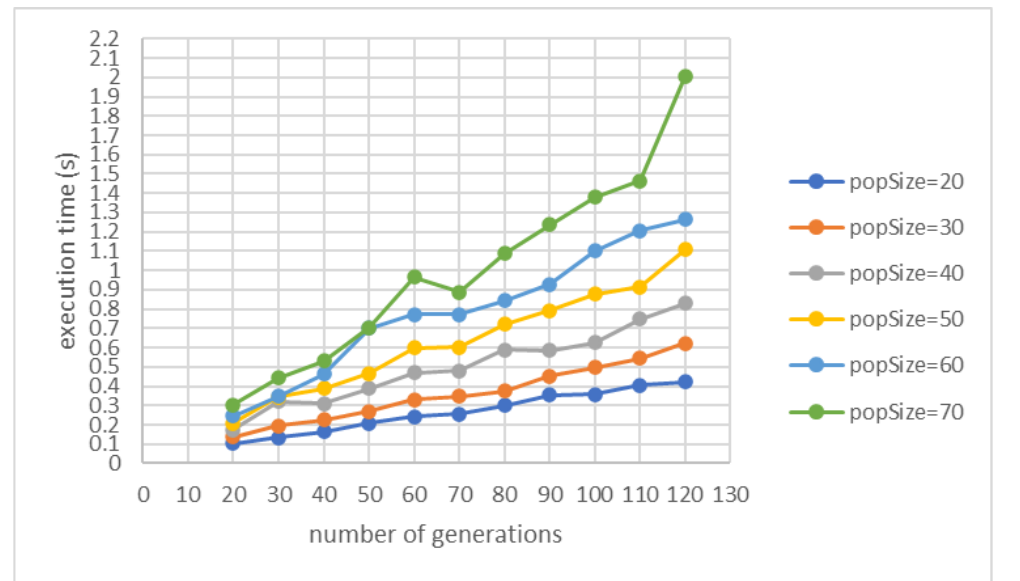
Figure 13. The execution time variation when number of generations is changed, and population size is maintained constant.